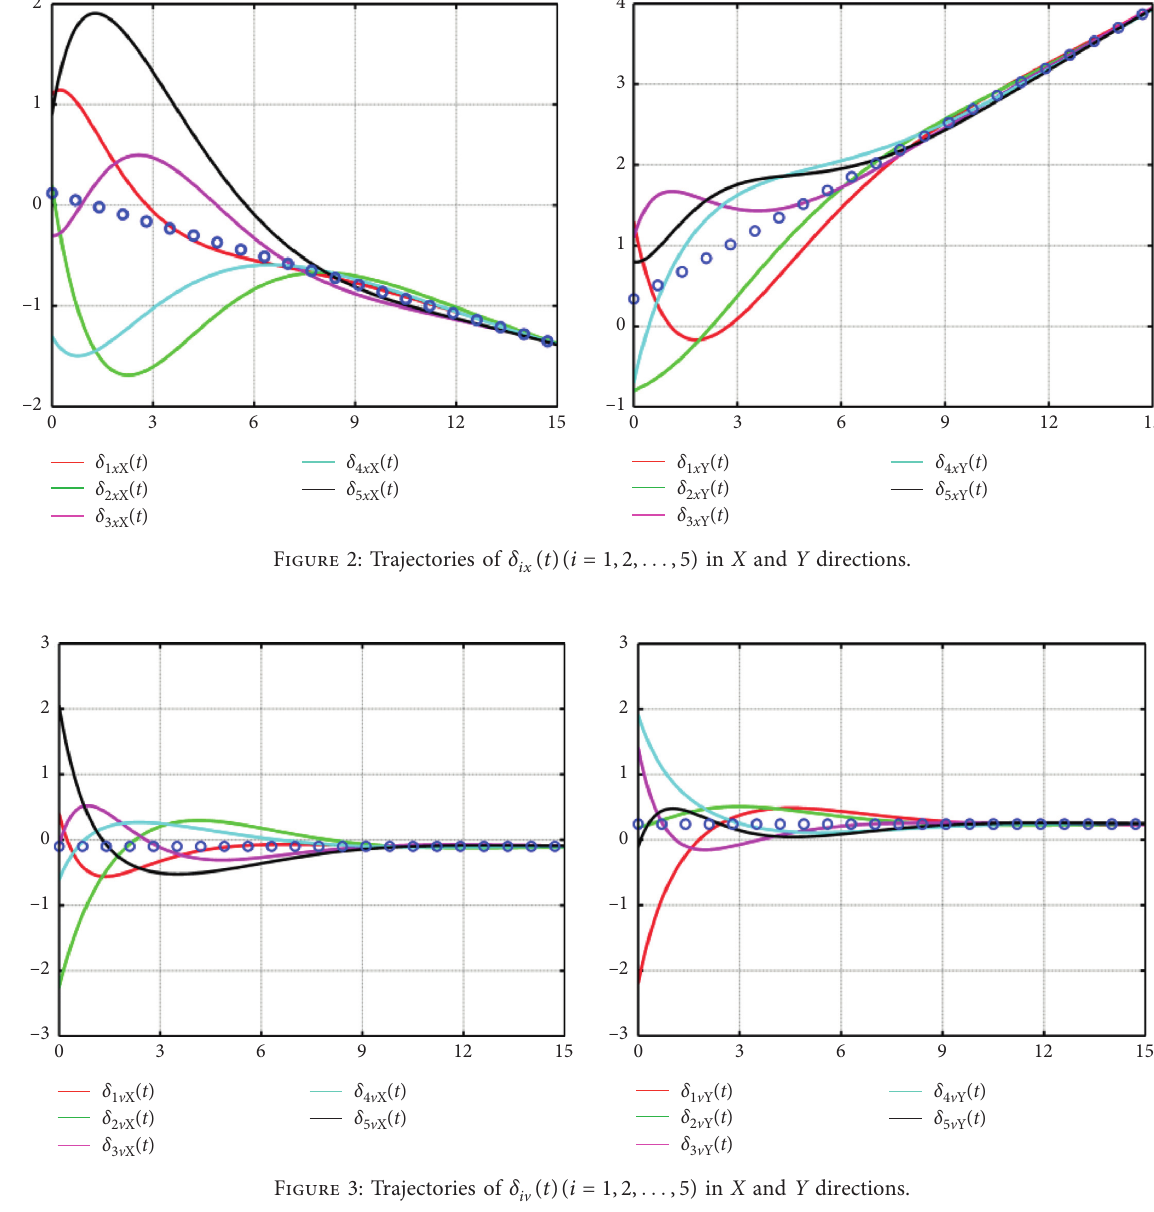
( t )( i � 1 , 2 , ... , 5 ) in X and Y iv